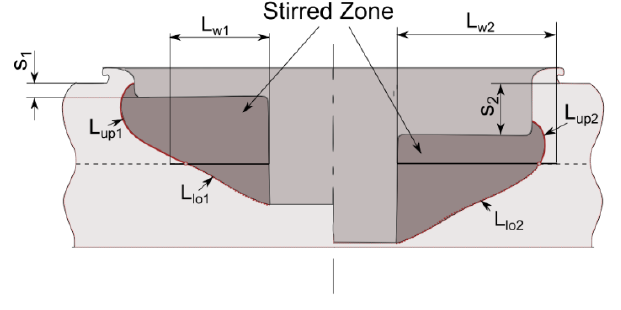
Figure 25. Effect of plunging depth on geometry of the weld [77]. Figure 25. E ff ect of plunging depth on geometry of the weld